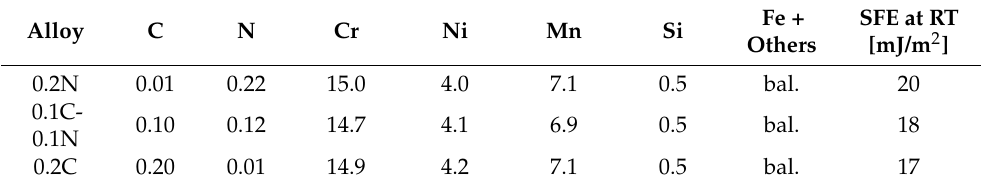
Table 1. Chemical composition of the investigated steels in wt.% and calculated SFEs at RT. Alloy C N Cr Ni Mn Si